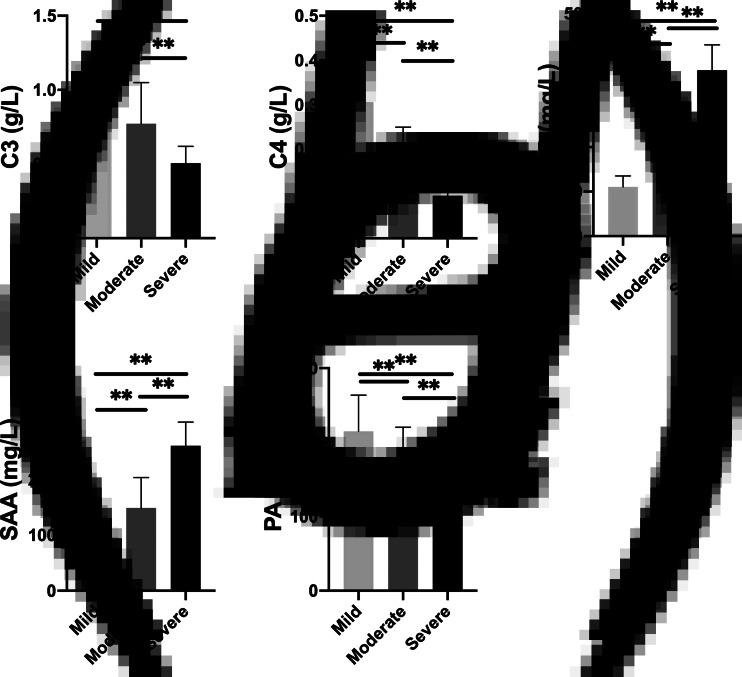
Different APRP contents in mild, moderate and severe cases of COVID-19 (*P < 0.05, **P < 0.01).